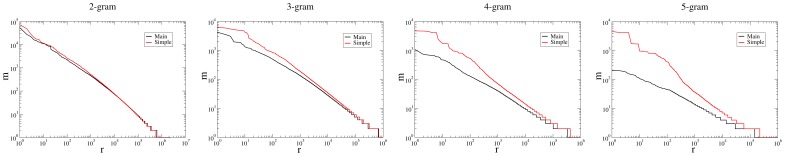
N-gram statistical analysis of Main and Simple.Condition WB, as explained the Methods section. Number of appearances of n-grams in Main (black) and Simple (red) for n = 2−5 from left to right. By increasing n, the difference between two samples becomes more significant. In Simple there are more of the frequently appearing n-grams than in Main.